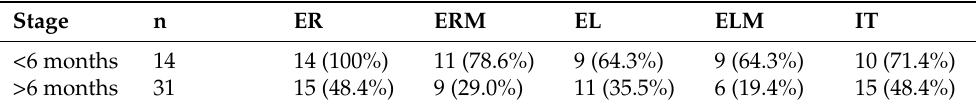
Table 4. Performance of the different combinations of amino acid mutations for detecting recent HIV-1